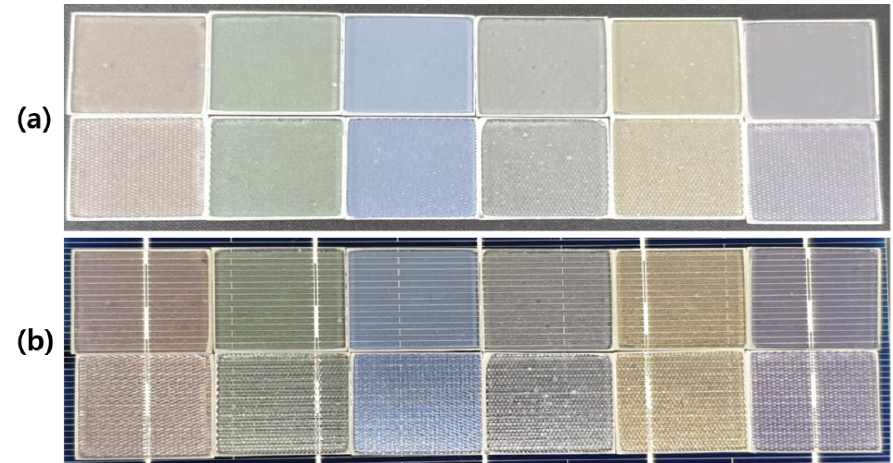
Figure 6. Actual photographs of color glass spin coated at 1500 rpm on ( a ) a black background and ( b ) on a solar cell. (First row: color glass on normal glass substrate, second row: color glass on mist glass substrate. From left to right: Dazzling Red, Dazzling Green, Splendor Blue, Dazzling Standard, Dazzling Gold, and Dazzling Violet).